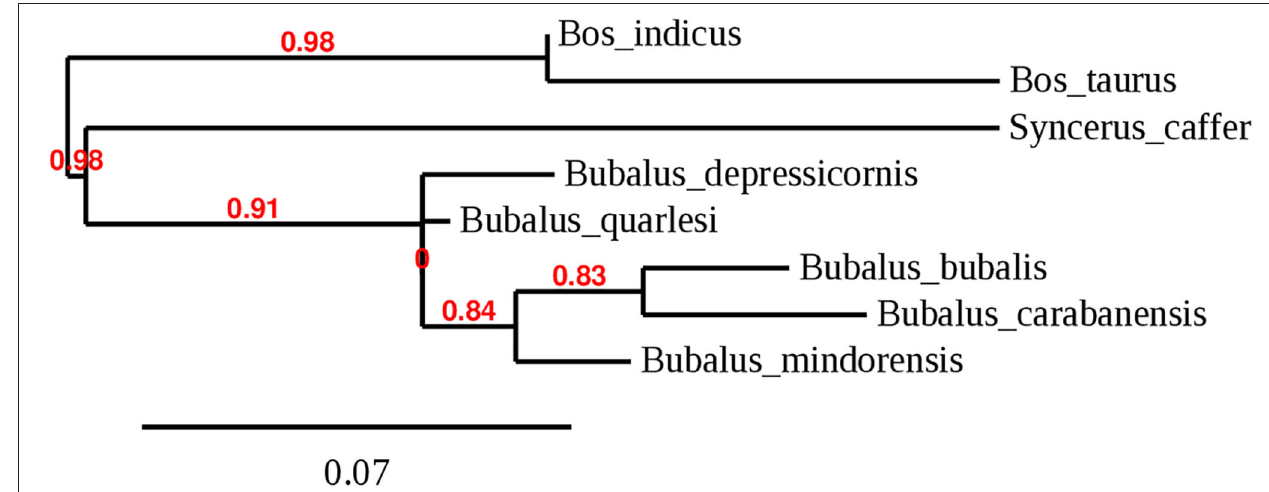
FIGURE 2 | Phylogenetic tree of the genus Bubalus based on D-loop region complementing with IOC and cytochrome